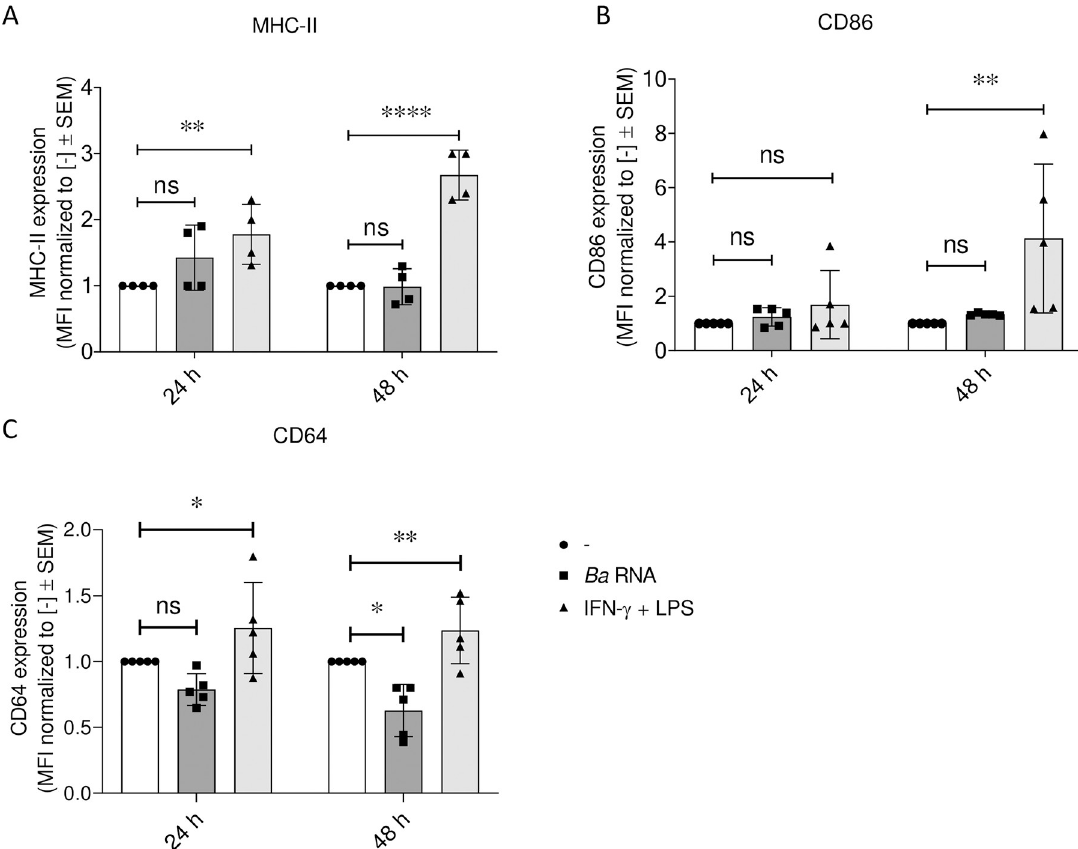
Fig 1. Ba RNA interferes with the expression of M1 markers at 48 h. Human M0 macrophages were stimulated with Ba RNA for 24 and 48 h. (A) MHC-II, (B) CD86 and (C) CD64 (M1 markers) expressions were determined by flow cytometry. Cells treated with IFN- γ and LPS were used as a positive control. Bars indicate the geometric means ± normalized to untreated cells ± SEM of at least four independent experiments. MFI, mean fluorescence intensity. ns, non-significant; � P < 0.05; �� P < 0.01; ���� P < 0.0001 vs. untreated cells